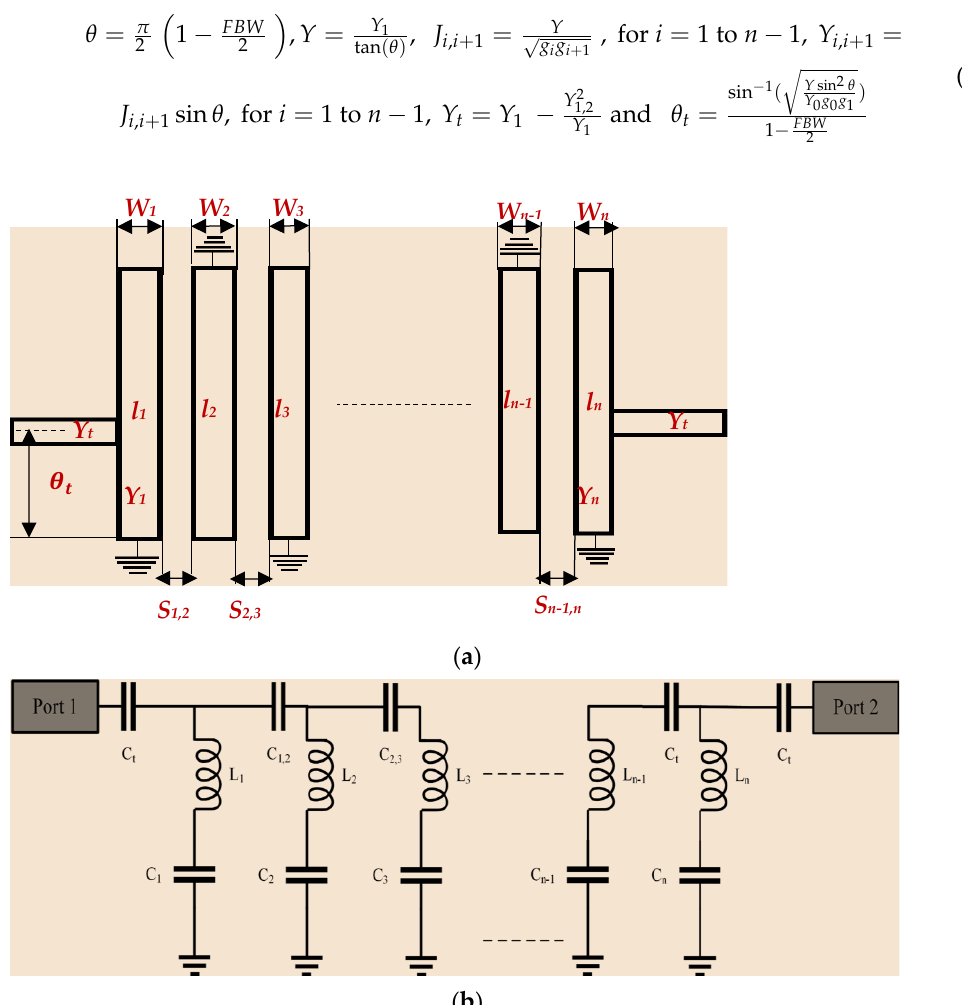
Figure 3. n order UTL IBPF ( a ) layout and ( b ) equivalent circuit .